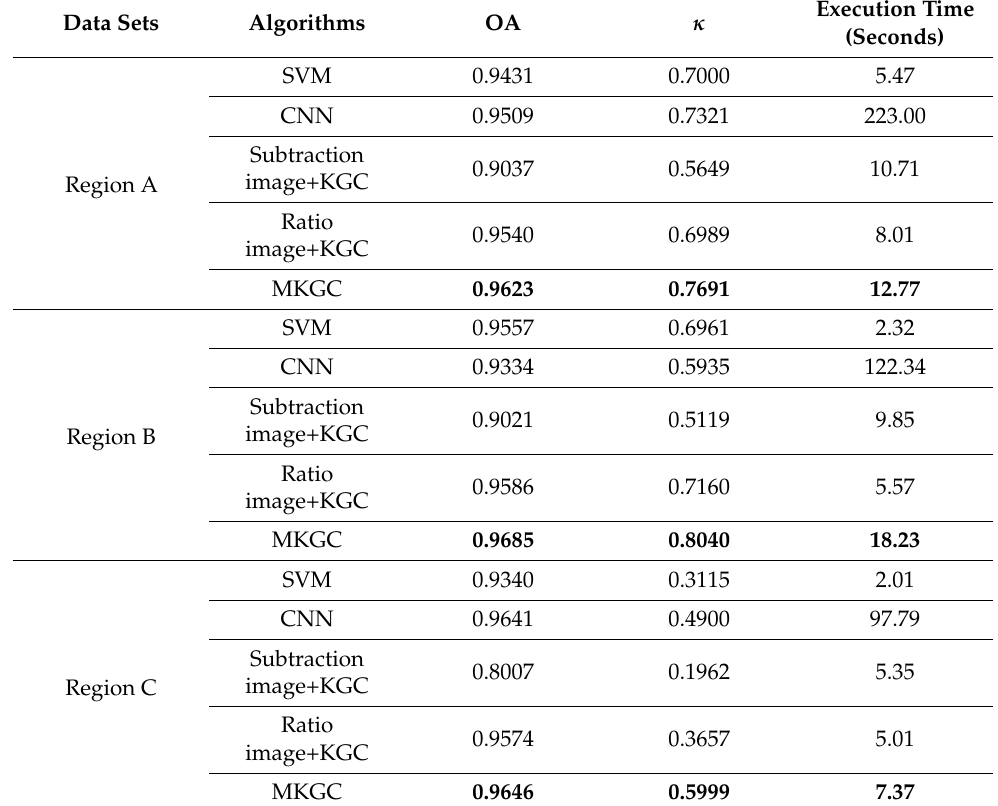
Table 2. Objective evaluation. Overall Accuracy (OA), Kappa Coefficient ( κ ) and Execution time. Bold numbers are results of MKGC